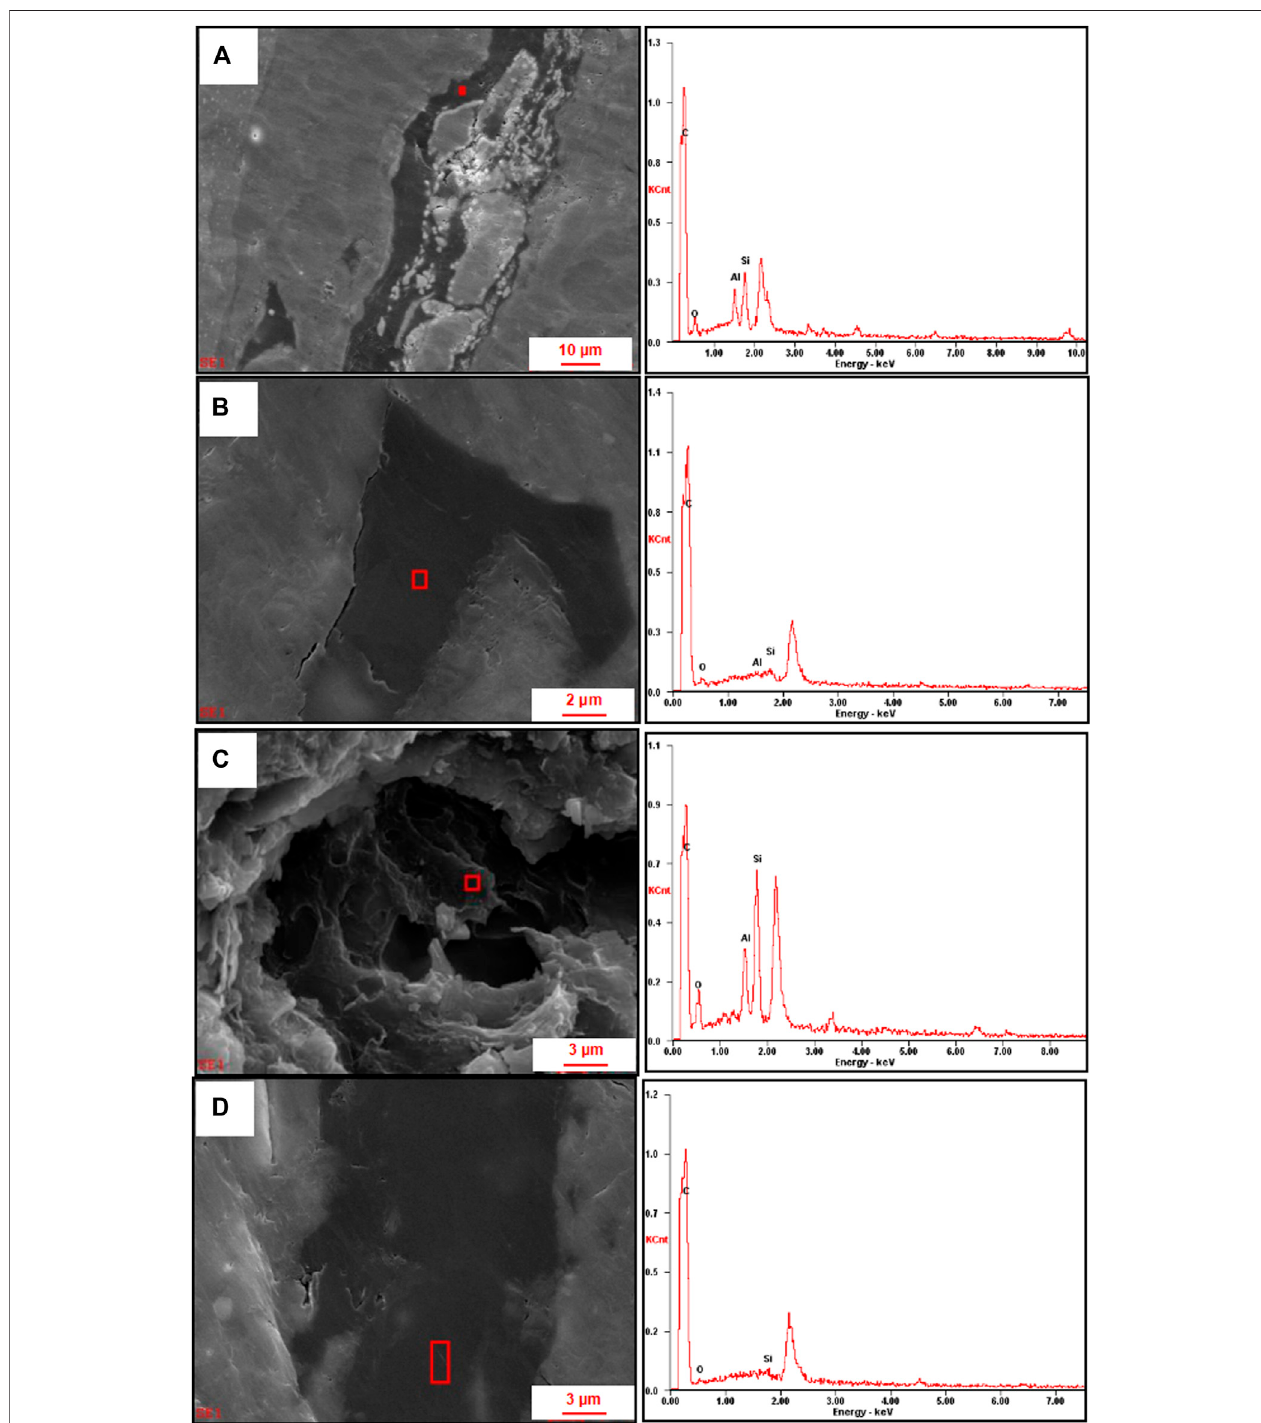
FIGURE 2 | SEM and EDS characteristics of organic matter (A) SEM and energy spectrum photos, showing morphological organic matter is fi lled with strawberry pyrite,Q129well,1667.48 m; (B) SEMandenergyspectrumphotos,showingmorphologicalorganicmatteris fi lledwithorganicpores,Q129well,1667.48 m; (C) SEM and energy spectrum photos, showing coexistence of kaolinite and amorphous organic matter, D19 well, 1369.93 m; (D) SEM and energy spectrum photos, showing amorphous organic matter with organic pores, Q12 well, 1667.48 m.